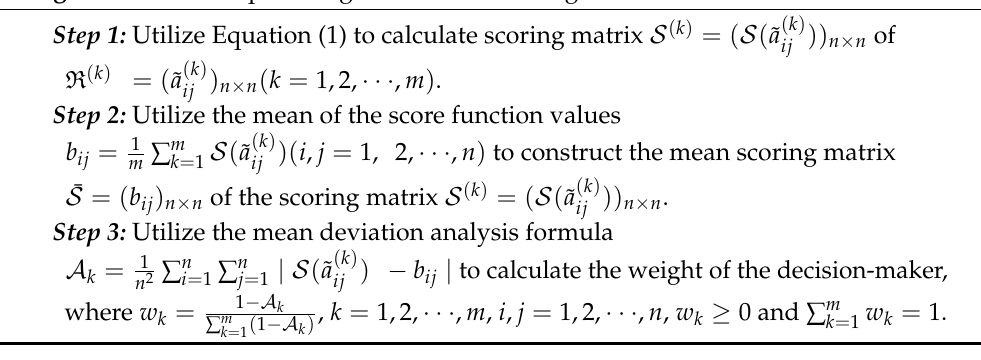
Algorithm 4: The expert weight determination